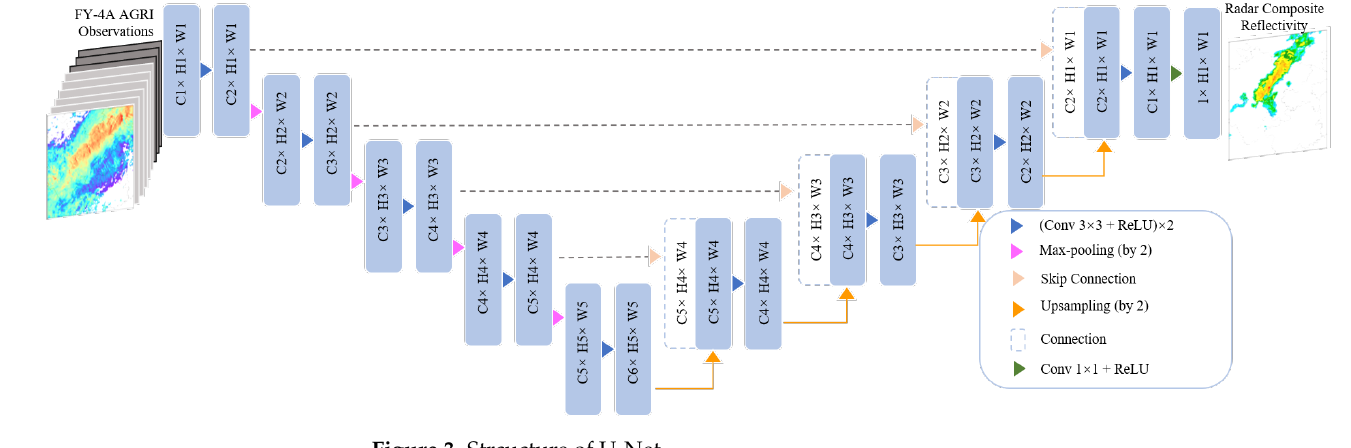
Figure 3. Strcucture of